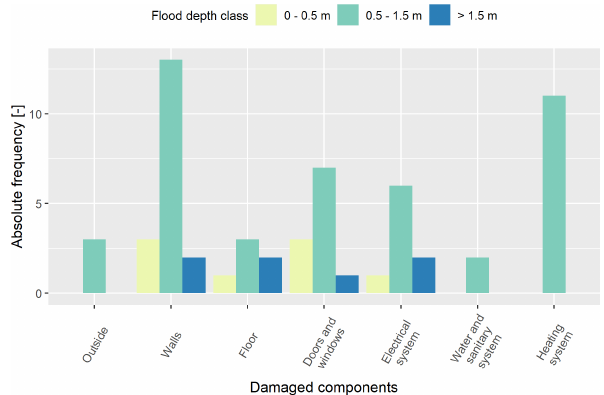
Figure 9. Absolute frequency of declared damage to the differ- ent building components in the outlier dataset for different water depth ( h )